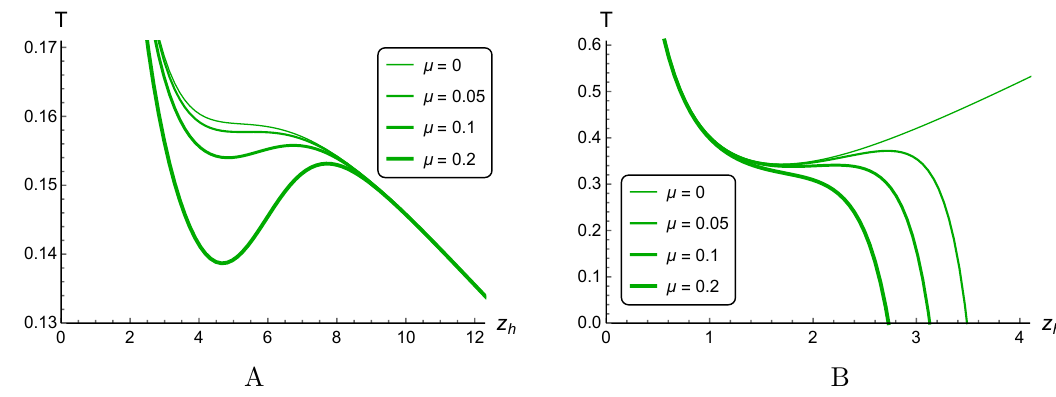
Figure 2 . Temperature as function of horizon for different µ in isotropic model for light (A) and heavy (B)